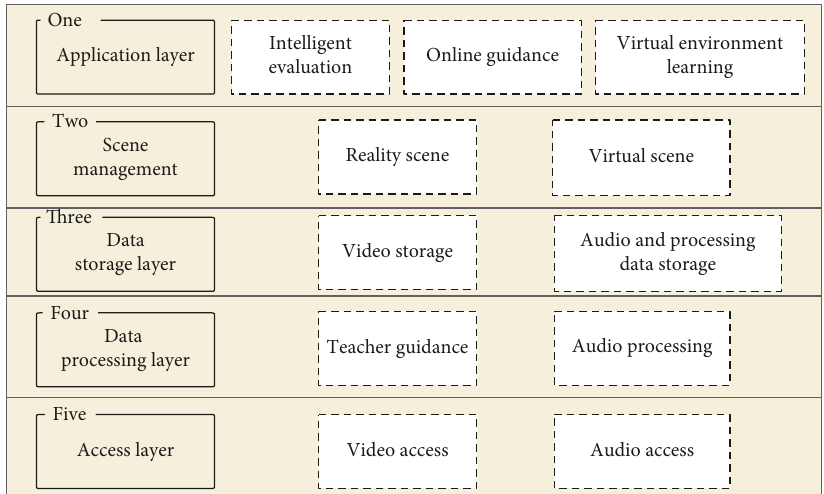
Figure 12: Music teaching system architecture.